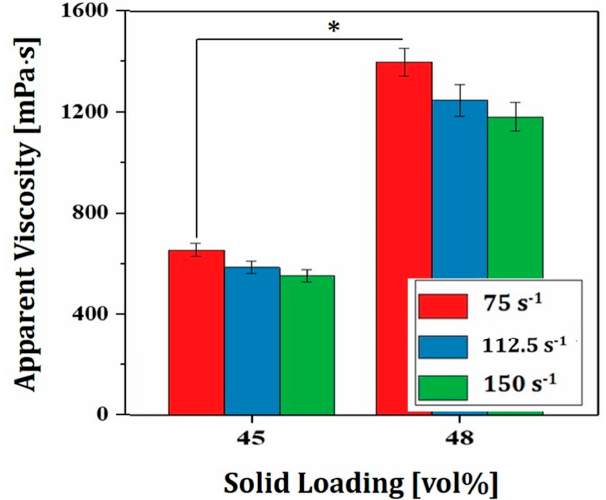
Figure 6. Apparent viscosities at various shear rates observed for 4Y-PSZ suspensions prepared using various solid loadings (45 vol% and 48 vol%) (* p < 0.05).